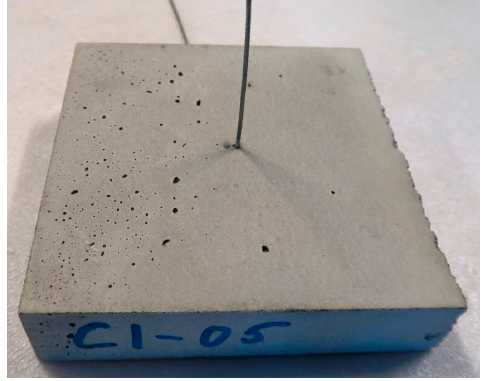
Figure 8. Representative cast specimen after testing.